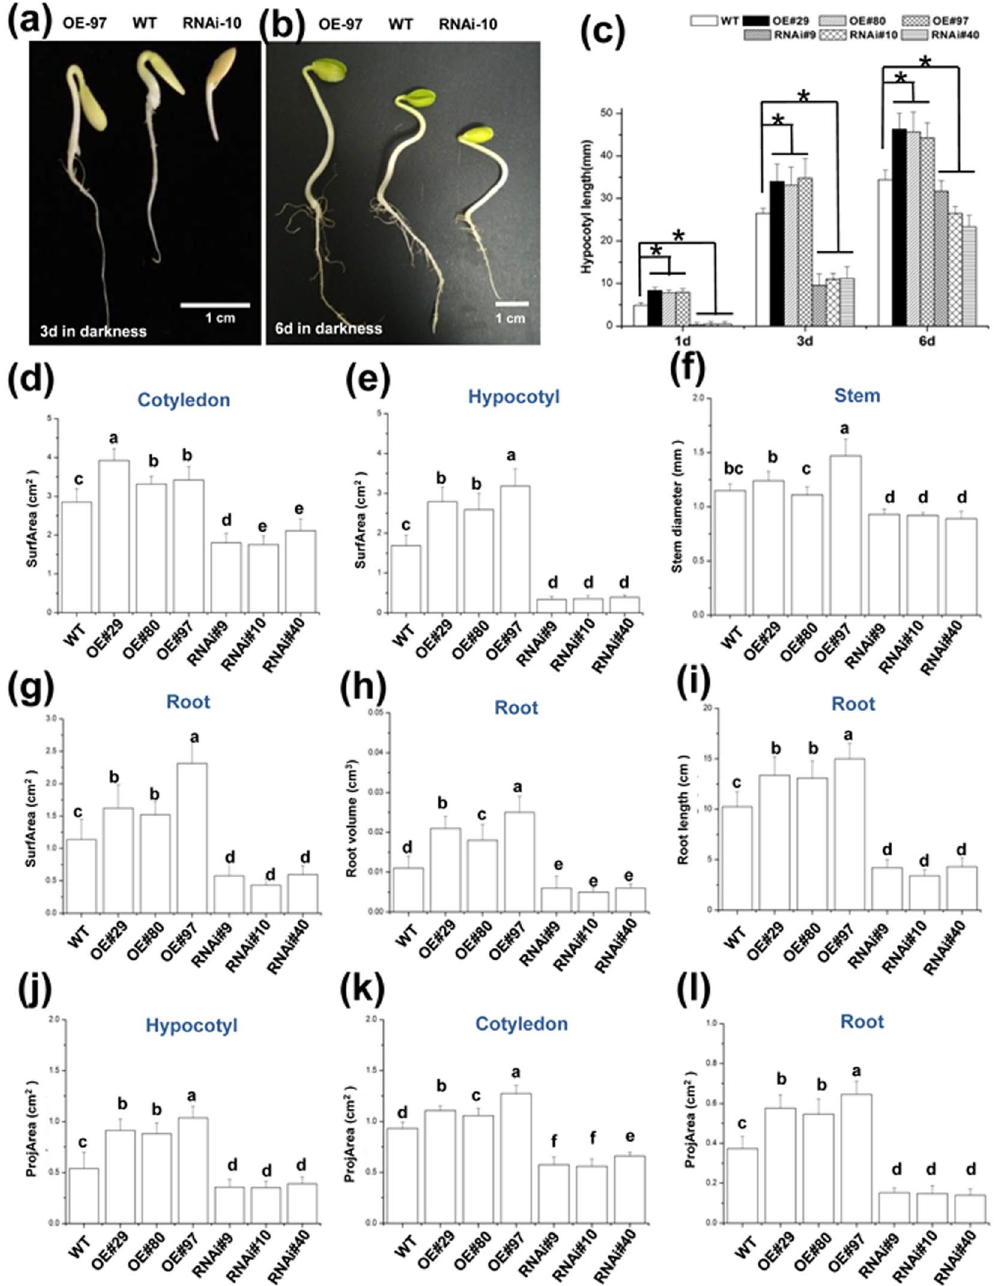
Figure 6. Changes to the morphological characteristics of transgenic cucumber lines. ( a , b ) Morphology of 3-d- old ( a ) and 6-d-old ( b ) WT and transgenic seedlings grown in darkness. WT and transgenic seedlings were grown in 9 cm diameter Petri dishes containing two layers of filter paper moistened with 5 mL of sterilized distilled water. Plates were incubated for 6 d at 30 °C in darkness. Seeds were considered to have germinated if the emerging radicle grew to 3 mm. WT (middle), OE ( CsGPA1- overexpressing transgenic plants, at left), and RNAi ( CsGPA1- silenced transgenic plants, at right) seedlings. Scale = 1 cm. Hypocotyl ( c ) length and ( e and j ) parameters, ( d , k ) cotyledon parameters, ( g – i and l ) root parameters, and ( f ) stem diameter of 6-d-old seedlings. The WT, OE, and RNAi seedlings were grown on plates supplemented with 5 mL of deionized water and then measured. Error bars correspond to the standard error of the mean. Values and data are presented as the mean ± standard deviation of three independent replicates with at least 20 seedlings counted per replicate. Values that differed significantly from the WT values are indicated. * p < 0.05 according to a Bonferroni post-hoc